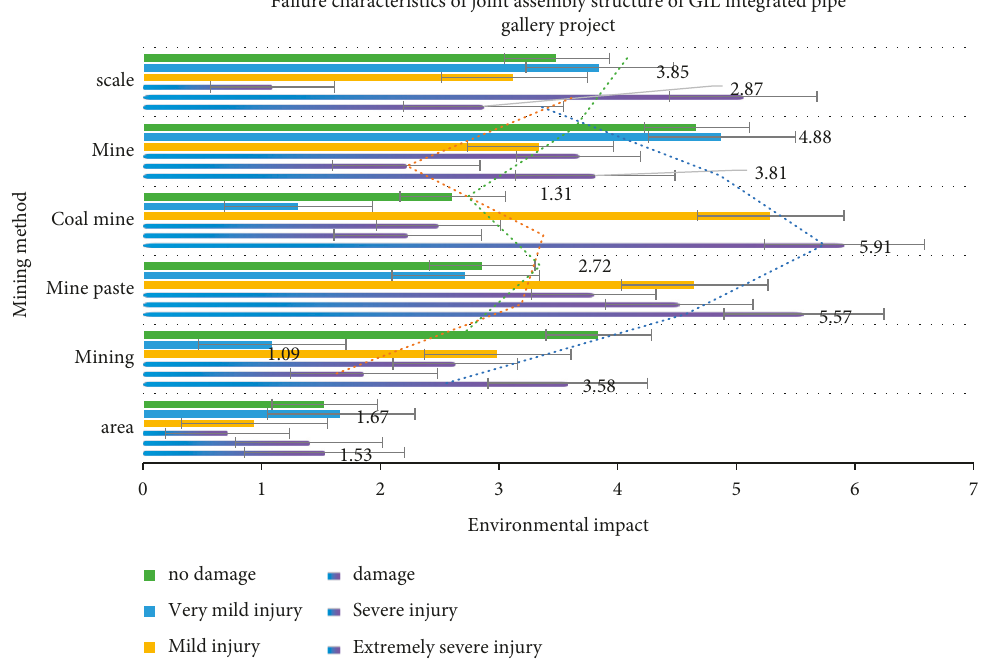
Figure 3: Failure characteristics of joint assembly structure of GIL integrated pipe gallery project.